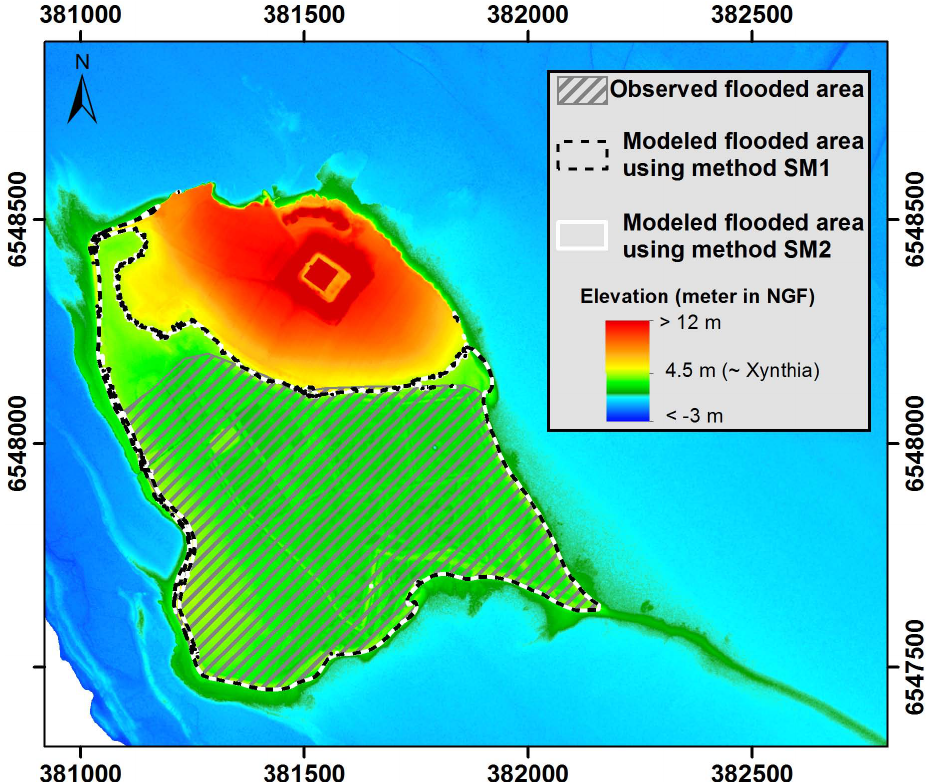
Fig. 5. Digital Terrain Model (DTM) of the Ile Madame Marsh (no. 12) showing the observed flooded area (hatched grey lines), the modeled flooded area using method SM1 (black dotted line) and the modeled flooded area using method SM2 (white